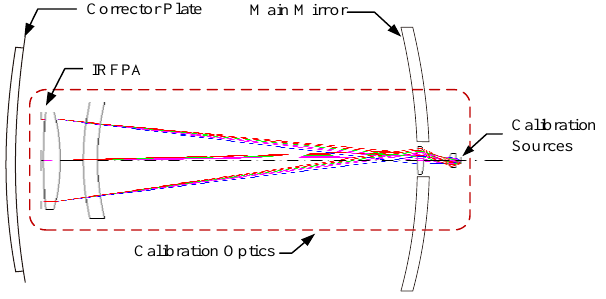
Figure 1. Schmidt telescope with modulated internal calibration sources (MICS).